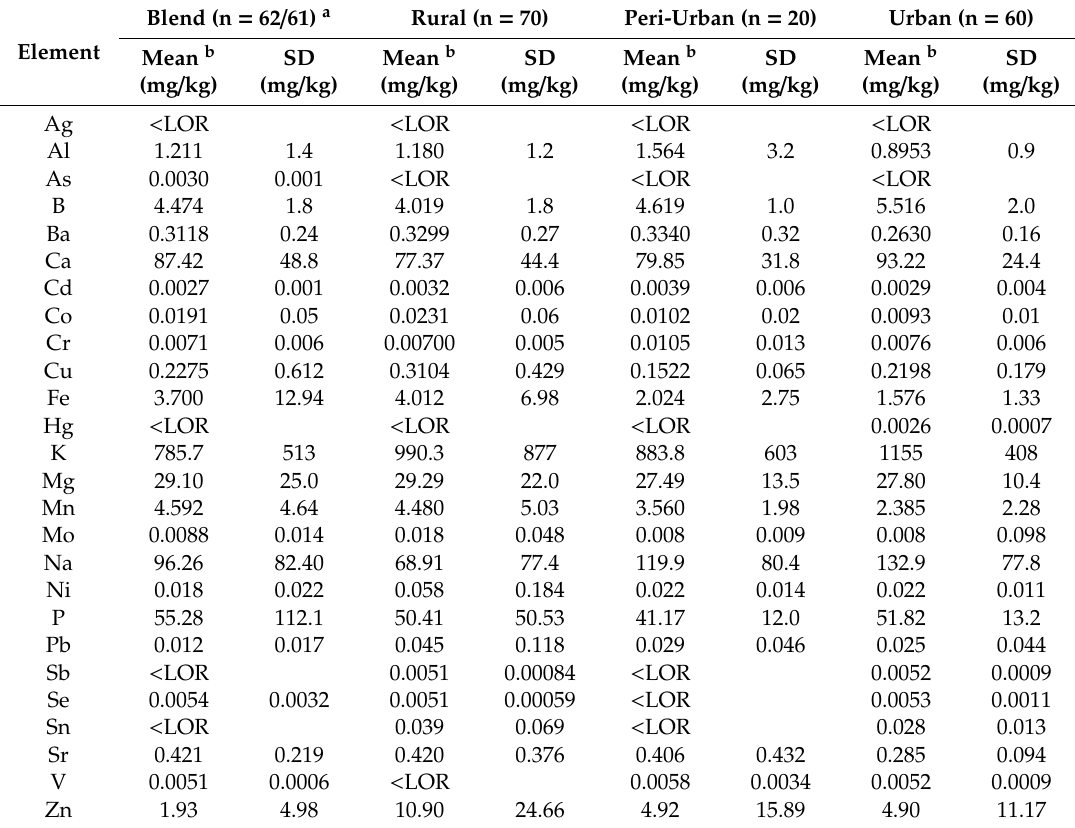
Table 2. Minerals, trace elements and heavy metals in honey, classified as blended, rural, peri-urban or urban in